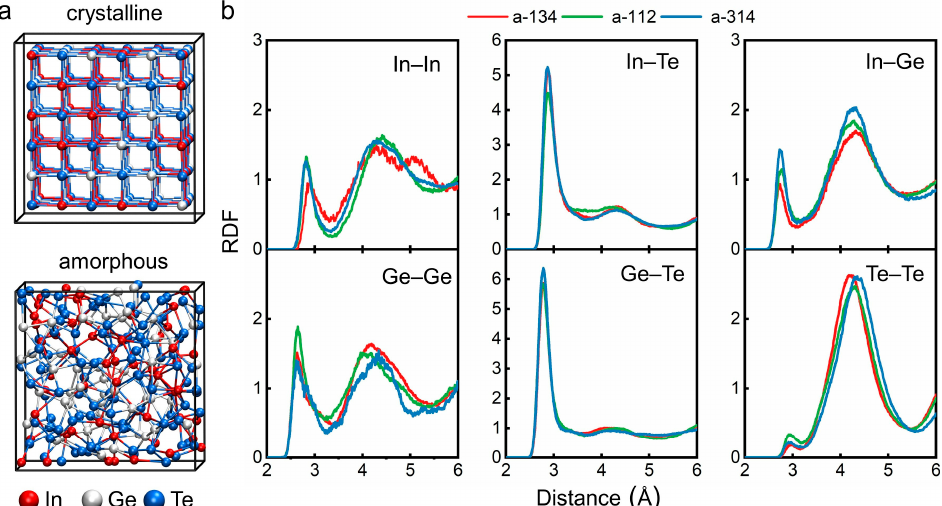
Figure 1. ( a ) Atomic structures for crystalline and amorphous InGeTe 2 . Red, silver and blue spheres represent In, Ge and Te atoms, respectively. ( b ) Partial radial distribution functions (RDFs) for each atomic pair in the three amorphous compounds. The “a-134”, “a-112” and “a-314” represent amorphous InGe 3 Te 4 , InGeTe 2 and In 3 GeTe 4 , respectively.